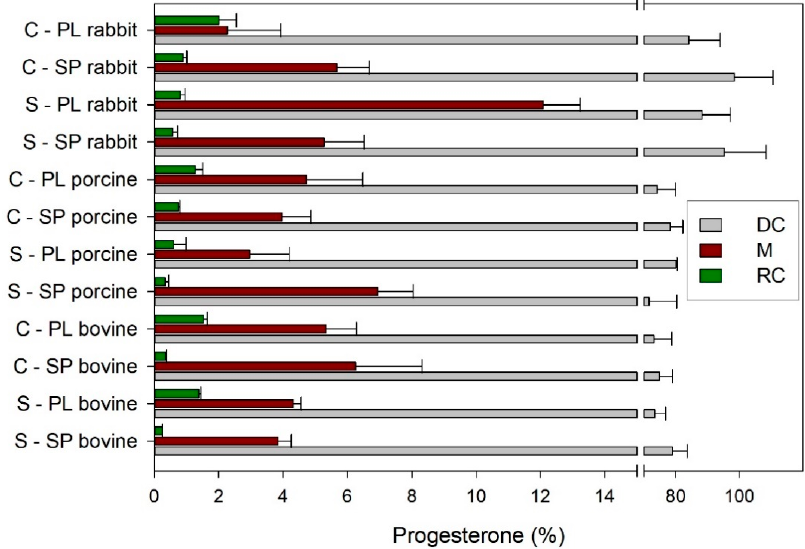
Figure 6. Mass balance, percentage (%) of PG accumulated in the donor compartment (DC); in the membrane (M) of bovine, porcine, and rabbit and in the receiving compartment (RC) after 4 h of experiment of permeation of micelles Soluplus (SP) and Pluronic (PL) in corneas (C) and scleras (S). The total polymer concentration was 20% w / w in all cases ( n = 4).